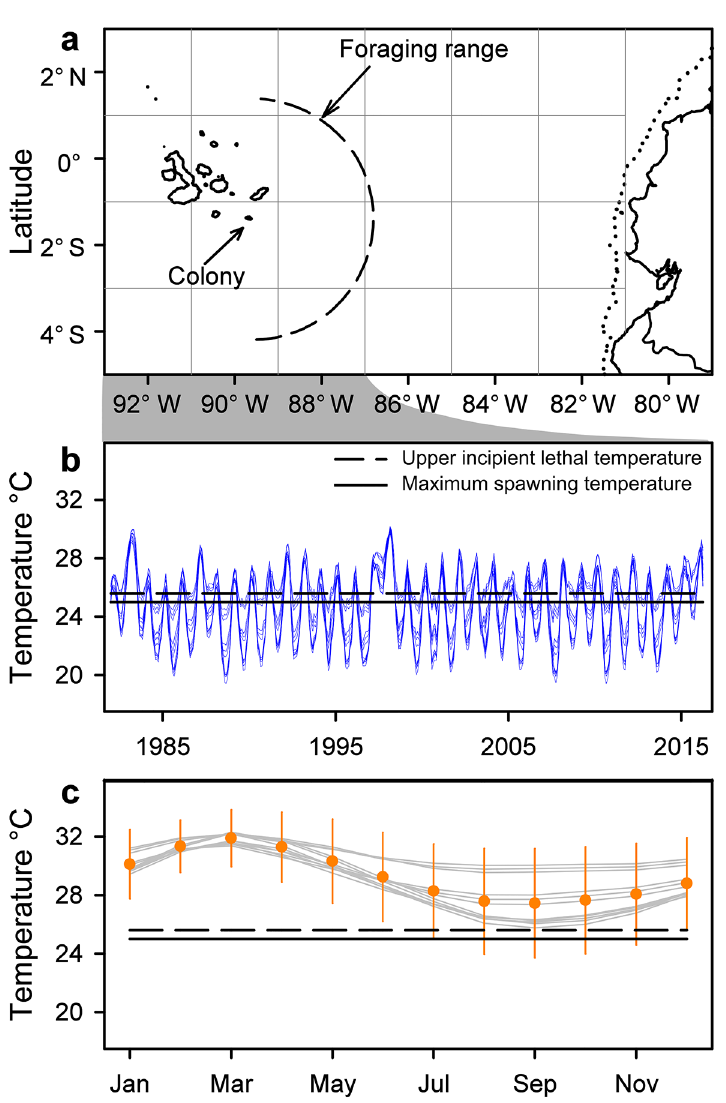
Fig 2. Recent SST + 4.5˚C, sardine spawning temperature, and Nazca booby foraging range. (a) Foragingenvelope [48] (semicircle)of breedingNazca boobiesfrom Isla Espa ñ ola, Gala´pagos. Most present- day trips are within the area of the semicircle. The potentialforagingrange, includingwest of the colony, includesparts of each of the western-most 12 blocks on the map. Dotted line to the east shows the continental shelf break (1000 m isobath), roughly indicating the distributionof continentalPacific sardines,a probable source populationfor Gala´pagos. (b) Recent temporalvariation(blue lines) in SST in each of 12 2˚ x 2˚ blocks within the present-dayforagingrange of Nazca boobies. Solid horizontalline shows upper limit of spawning SST range of Pacific sardines(25˚C; [45–47]).Dashedhorizontalline shows upper incipient lethal limit for warm-acclimated temperate-originPacific sardines (25.6˚C; [44]). (c) Recent SST from (a) with 4.5˚C warmingexpectedwithin 100 years. Orange pts ( ± 2 S.D.) show expectedtemperature averagedacross all 12 blocks and across all years (1982–2016) by month. Gray lines show temperatures averaged across all years, by month, for each individualblock. Monthly SST values for each 2˚ x 2˚ block were downloaded on 12 May 2016 from http://iridl.ldeo.columbia.edu/SOURCES/.NOAA/.NCDC/.ERSST/.version3b/.sst/.